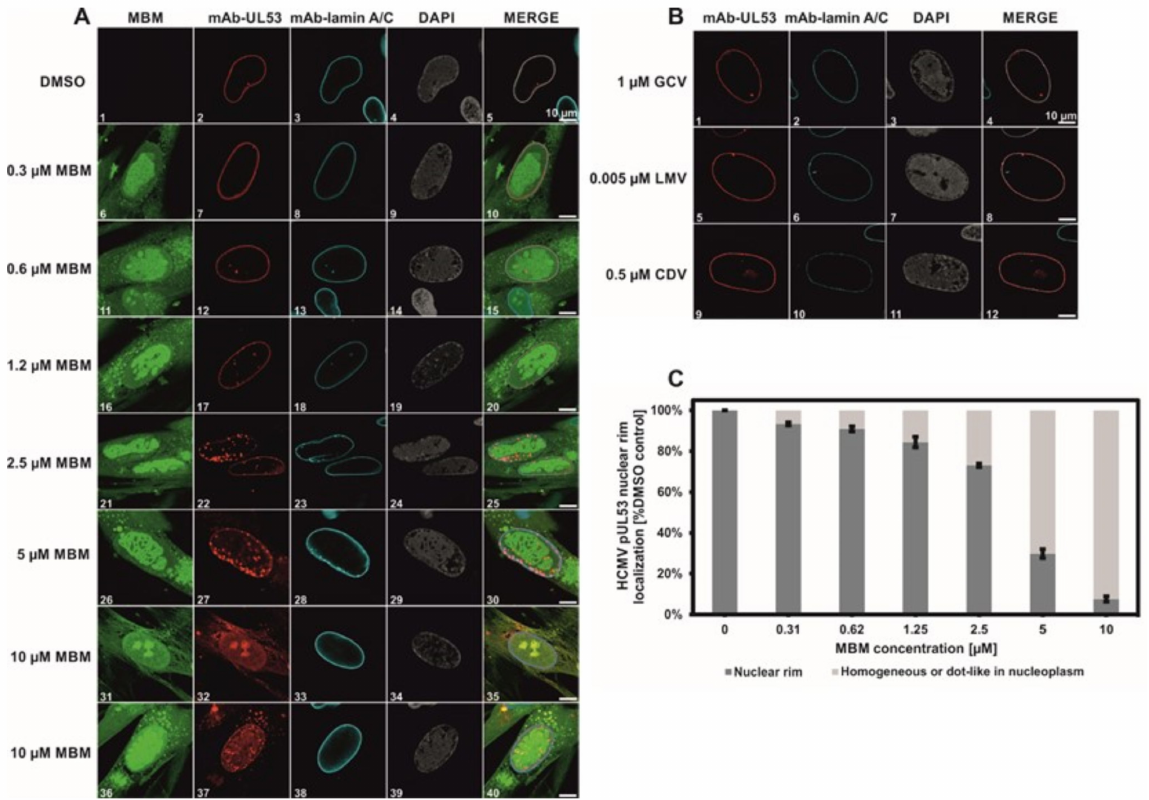
Figure 5. Merbromin (MBM, ( A )), but not GCV, LMV, and CDV ( B ), interfere with HCMV nuclear egress complex (NEC) nuclear rim formation in HCMV-infected human foreskin fibroblasts (HFFs). ( A ). Confocal imaging (indirect immunofluorescence staining) of viral pUL53 and cellular lamin ( A / C ). Counterstainings of the autofluorescent merbromin and the nuclei (DAPI) are shown, and a merge of all signals is given. ( C ). Quantitation of the concentration-dependent inhibition of normal pUL53 nuclear rim localization by merbromin. Error bars present SDs of three experiments. Scale bars indicate 10 µ m. See Section 2.6 for experimental